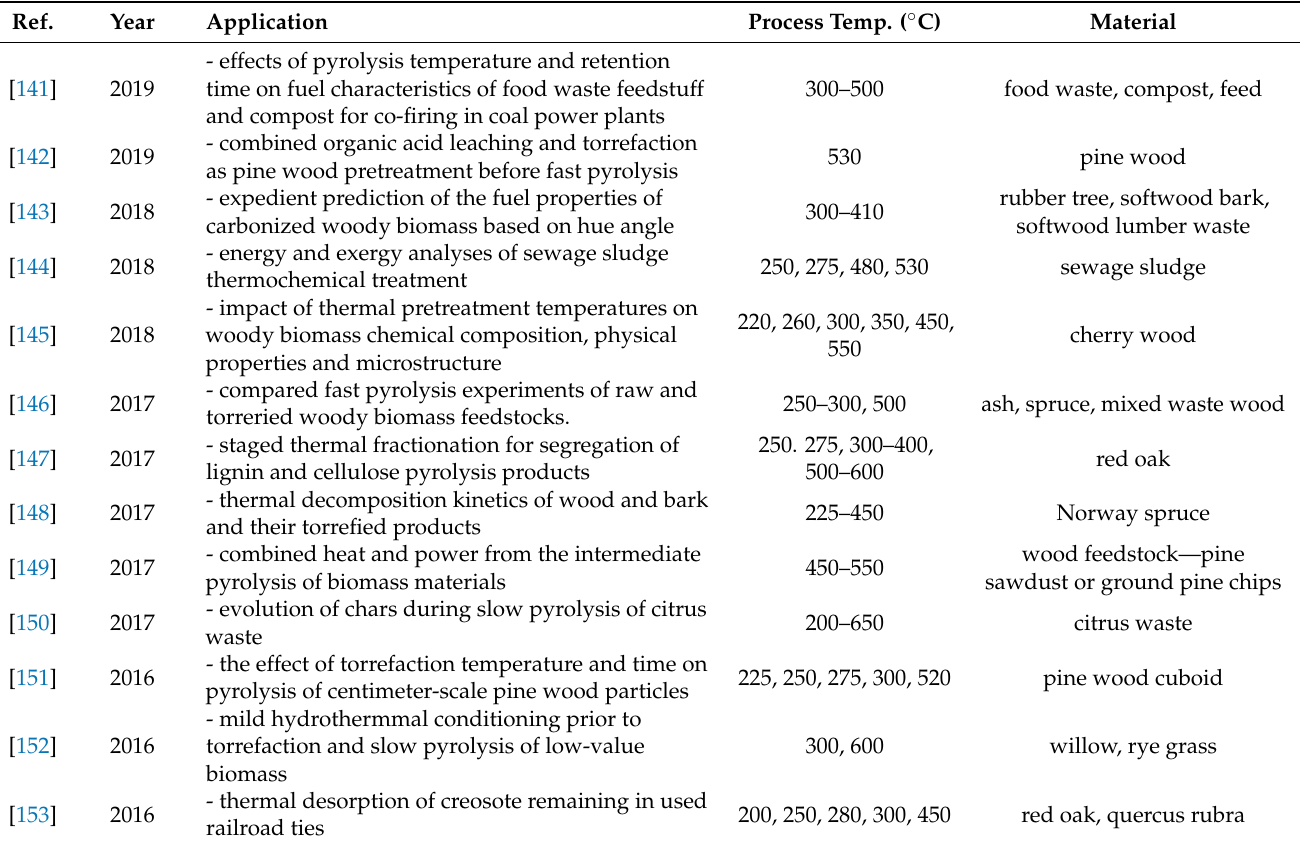
Table A3. The use of torrefied biomass in the pyrolysis process—detailed thematic analysis.